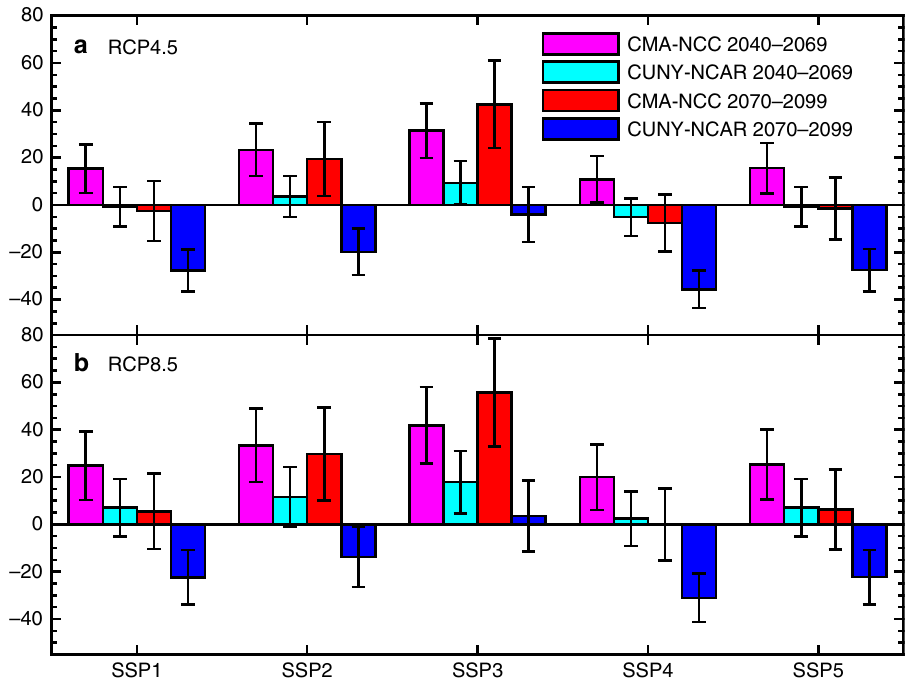
Fig. 5 Future changes in fl ash drought risk averaged over China under different warming and socioeconomic scenarios. The risk changes under ( a ) RCP4.5 and ( b ) RCP8.5 (% relative to the 1970 – 1999 present-day level) scenarios based on 29 realizations with different combination of CMIP5 climate models and land surface models (see Supplementary Table 1 for details). Population under SSPs 1 – 5 from CMA-NCC and CUNY-NCAR were used to estimate exposure risk, where the former considered the recent two-child policy in China. All the statistics were calculated during the growing seasons (April – September). The black bars show 5 – 95% uncertainties which were estimated by using bootstrapping for 10000